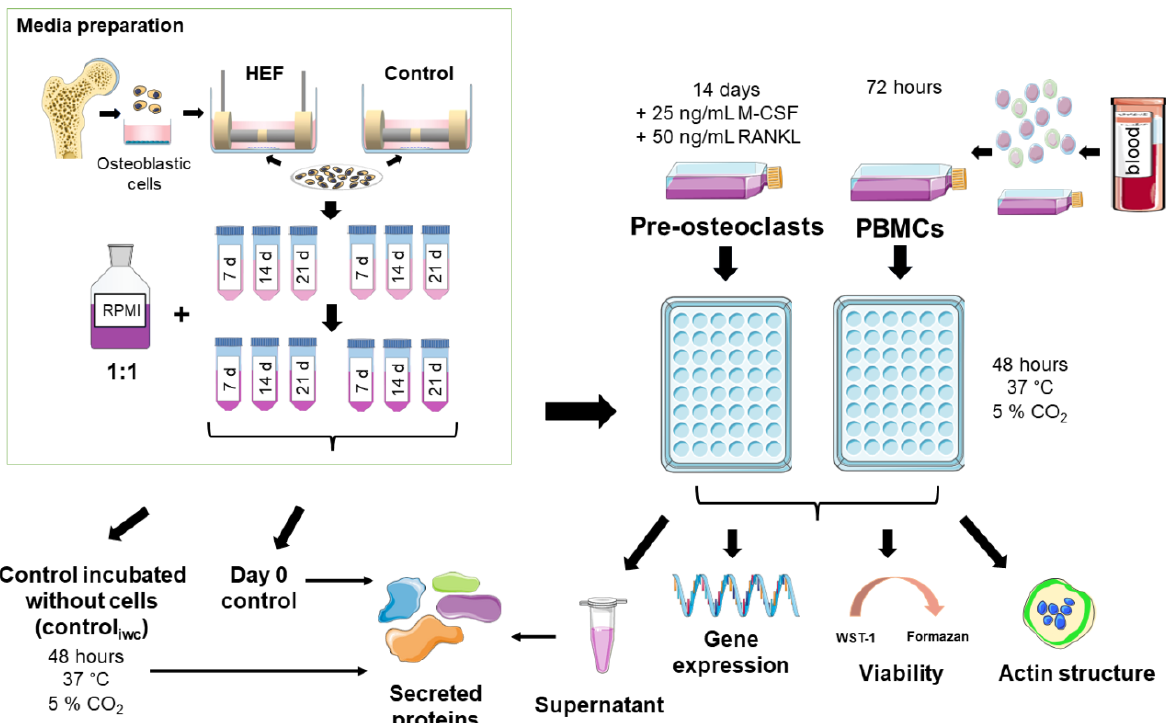
Figure 2. Schematic overview of the used methods. Single pictures were used from Servier Medical Art (http://smart.servier.com/, accessed on 23 May 2022) or bioicons (https://bioicons.com/, 23 May 2022).